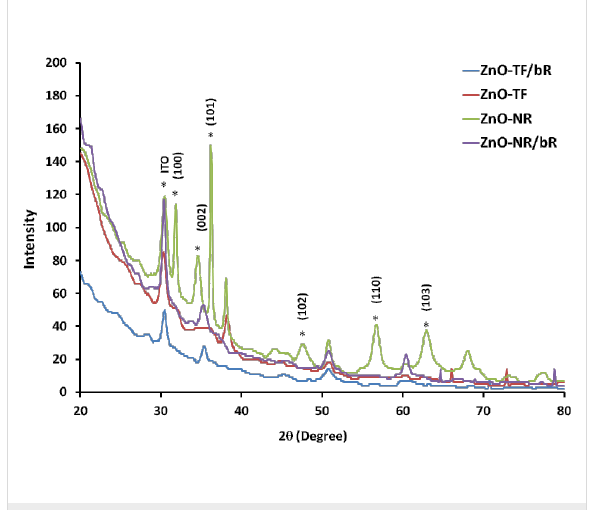
Figure 1: Comparative XRD patterns of the ZnO-TF, ZnO-TF/bR, ZnO-NR and ZnO-NR/bR